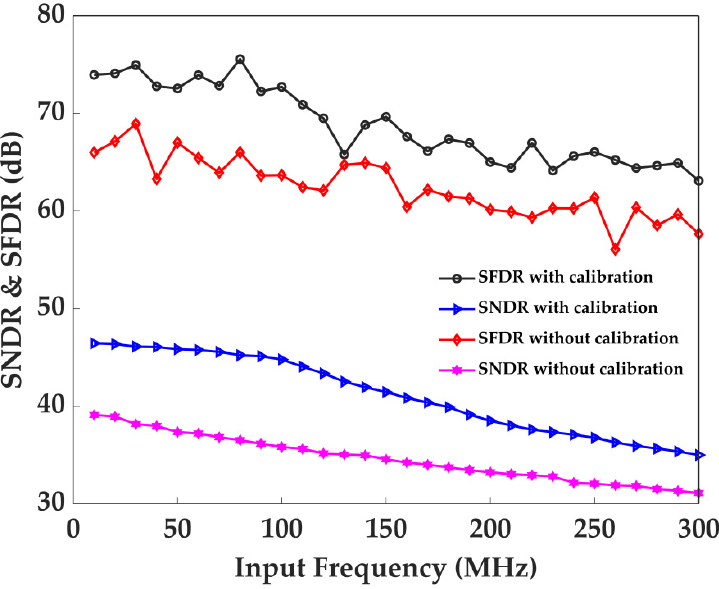
Figure 16. Measured SNDR and SFDR plots versus input frequency with or without online calibration.